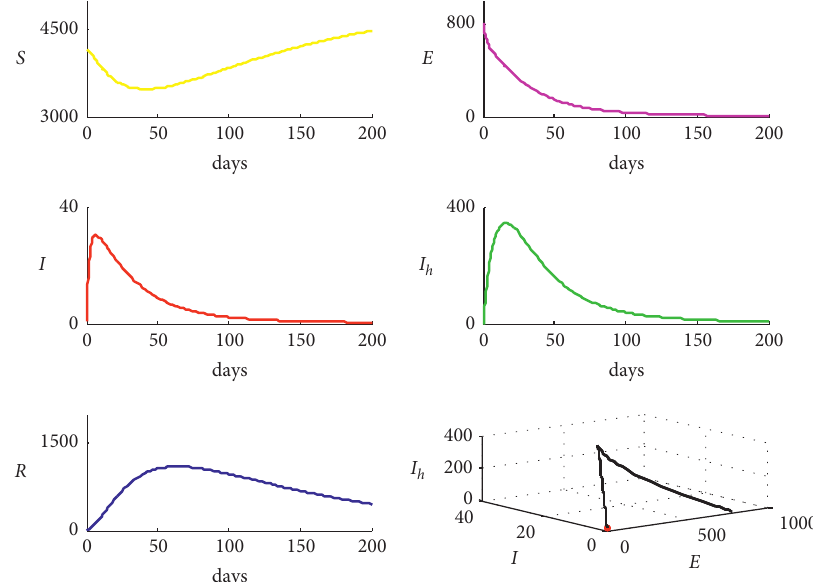
Figure 5: The trajectory of system (1) approaches to disease-free equilibrium point for the data in Table 2 with q � 0 .